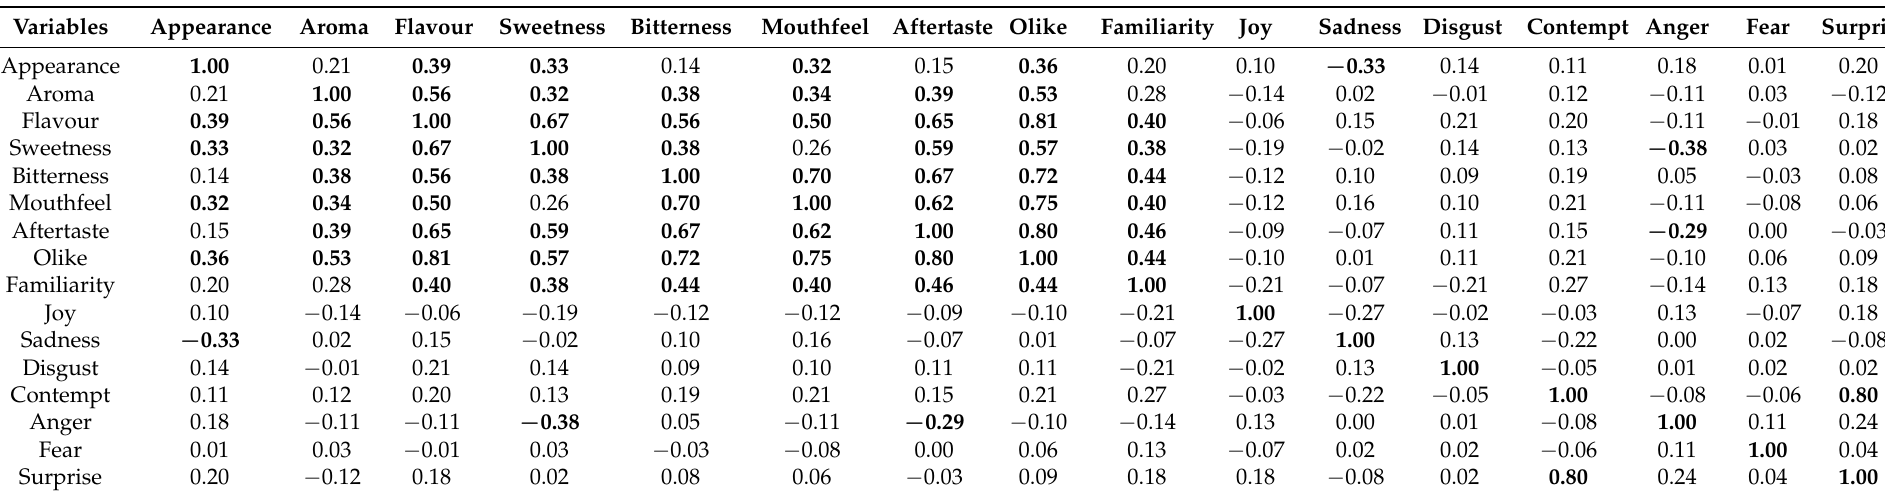
Table 6. Pearson correlation coefficient matrix among the sensory attributes, familiarity, liking and emotions for energy